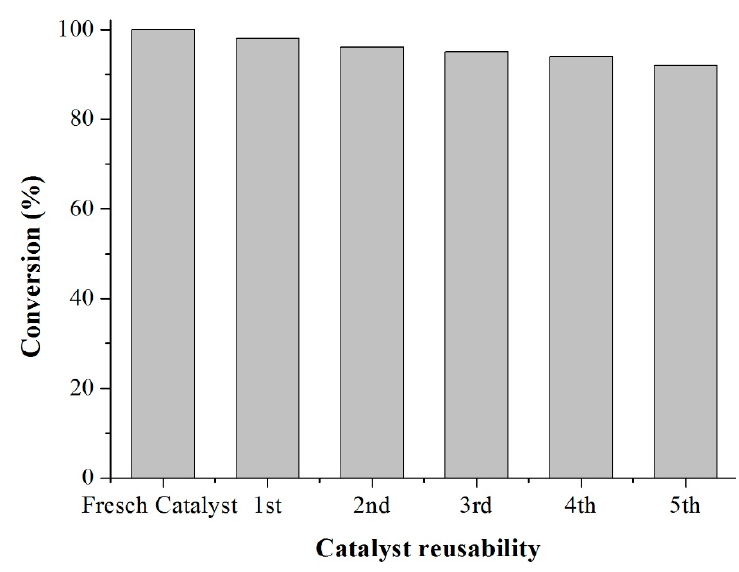
Figure 12. Reusability the 10HPMo/AlSiM catalyst.